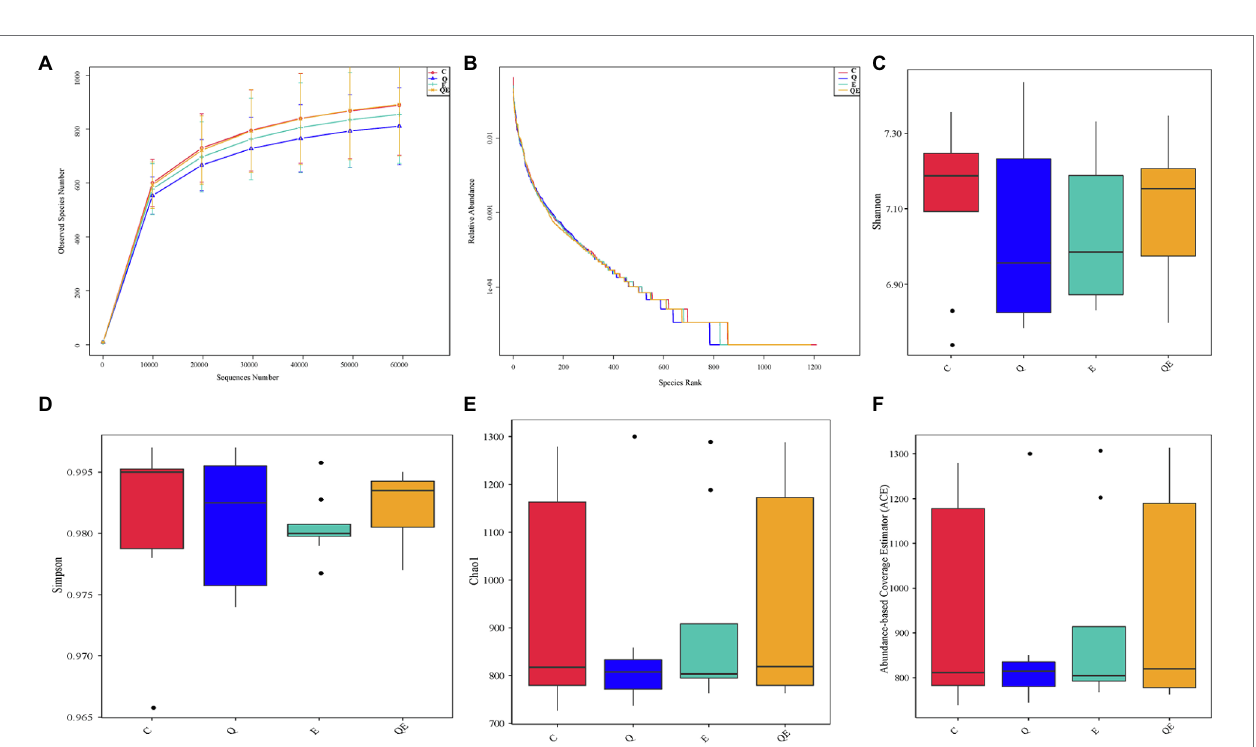
FIGURE 2 | Effects of dietary treatments [(control group (C), quercetin group (Q), vitamin E group (E) and combination of quercetin and vitamin E group (QE)] on cecal microbiota diversity and composition in aged breeder chickens. (A) Rarefaction curves, computed at the subsample size of 6,000 per sample, exhibit the effects of sequencing efforts on the observed number of OTUs at 97% sequence similarity. The error bars represent standard deviation of the eight replicates. (B) Abundance curve of species identified. (C) Shannon diversity index boxplot. (D) Simpson diversity index plot. (E) Chao1 diversity index boxplot. (F) Abundance-based coverage estimator (ACE) diversity index